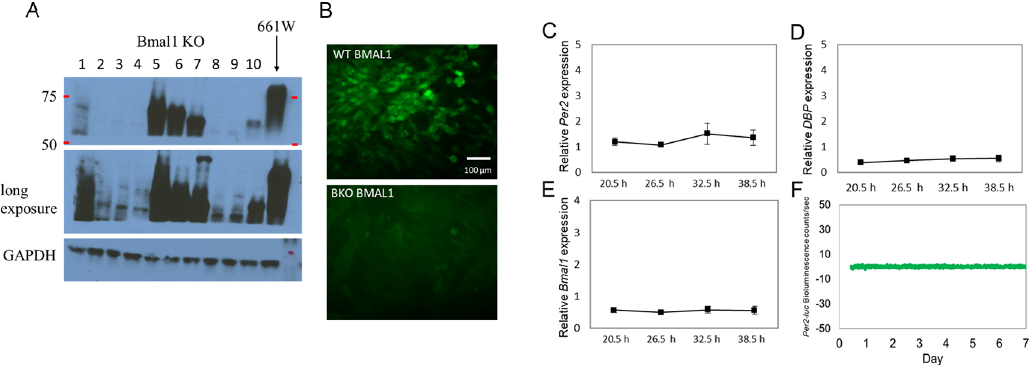
Figure 2. Removal of Bmal1 from 661W cells abolished circadian oscillation in 661W cells. (A) Western blot indicating the successful knockout of BMAL1 in multiple cell lines (i.e., lines 2, 3, 4, 8, and 9); others show a truncated Bmal1 (i.e., lines 5, 6, 7, and 10). (B) BMAL1 immunoreactivity was detected in 661W cells (upper panel), but not in a BKO cell line (line 4) (lower panel). (C to D) Loss of rhythmicity in Per2, DBP, and Bmal1 mRNA levels in BKO cells (one- way ANOVA, p > 0.05 in all cases, n = 6). (F) 661W-BKO cells no longer exhibit Per2-luc bioluminescence rhythm (detrended data) as observed in Figure